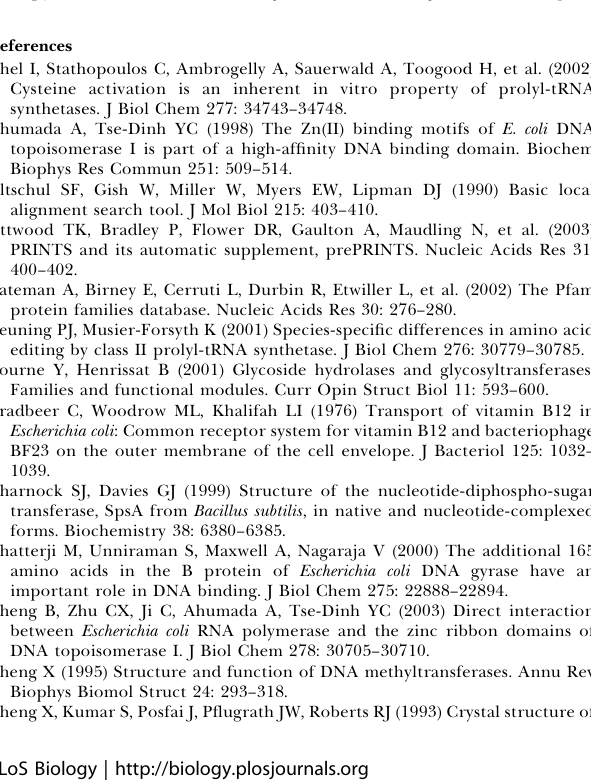
Figure S4. Multiple Alignment of B. subtilis Gene yhdY and Its Homologs YhdY is currently annotated as a hypothetical protein and contains a conserved domain for mechanosensitive proteins (the middle region of the alignment) and two variable domains (N- and C-termini). Figure S5. Multiple Alignment for H. pylori Gene HP1299 It is the methionine aminopeptidase (type Ia map ). This is an example of a fully conserved gene. Found at DOI: 10.1371/journal.pbio.0020081.sg005 (1.87 MB EPS). Figure S6. Multiple Alignment for H. pylori Gene HP1037 It is currently annotated as ‘‘ conserved hypothetical protein. ’’ The N- terminal region is variable. The conserved C-terminal domain is characteristic of methionine aminopeptidase. Figure S7. Length Distribution of Variable Regions in the Genome of H. pylori Shown as a histogram. Only variable regions inside fully conserved genes and SVGs are included. Pink line shows the domain size distribution in 3D-structure database (data from Wheelan et al. 2000). Table S1. Classification of Genes into Three Broad Categories Found at DOI: 10.1371/journal.pbio.0020081.st001 (62 KB